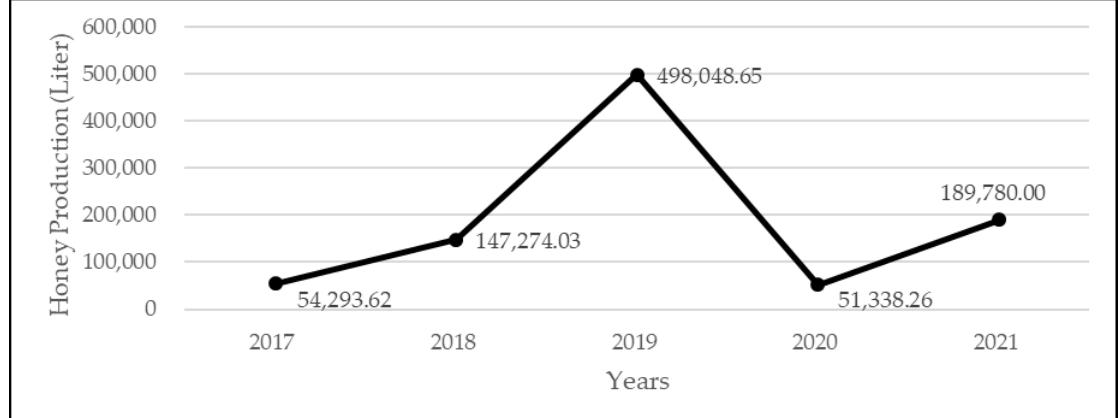
Figure 3. Production of honey in Indonesia 2017 – 2021 [8].